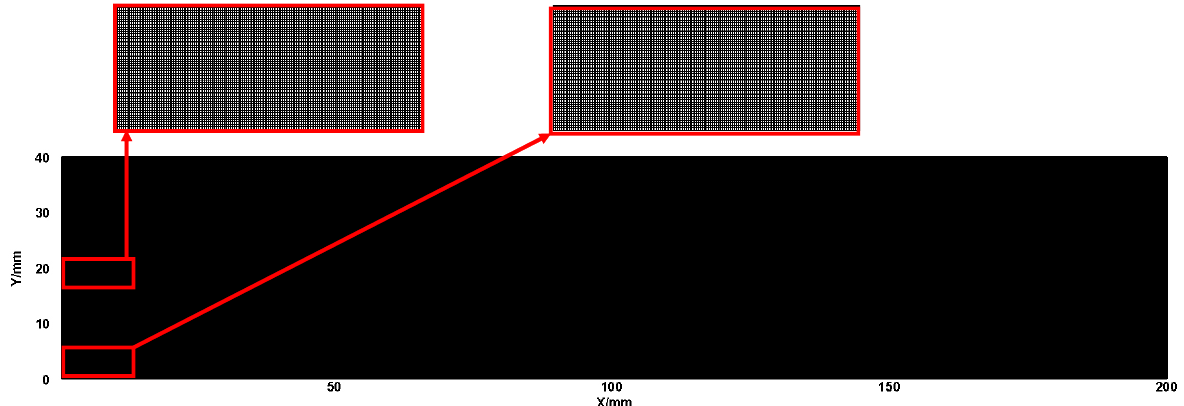
Figure 2. Computational mesh distribution.